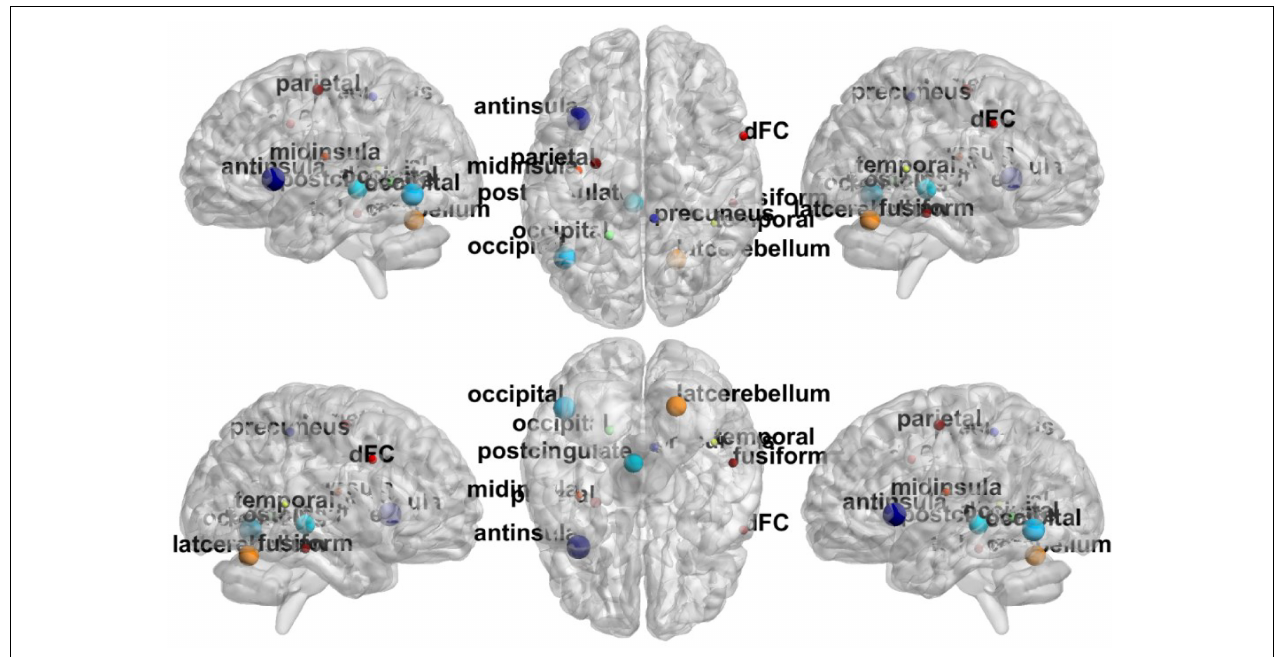
FIGURE 7 | The full view of most relevant ROI associated with the ASD classification task based on BHM- (cid:127) . This visualization is created using the BrainNet Viewer (https://www.nitrc.org/projects/bnv/).